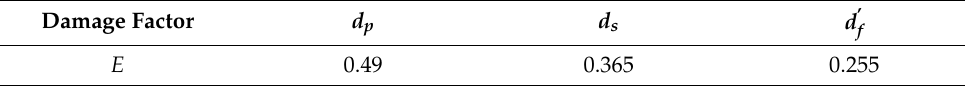
Table 6. Protection efficiency calculation